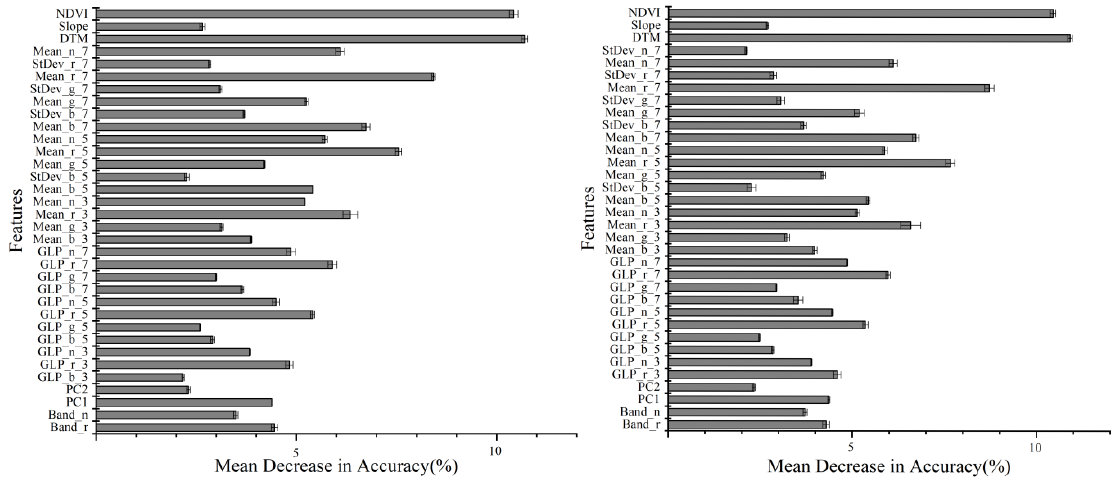
Figure 7. The average and standard deviation values of mean decrease in accuracy for different features in feature subset 1 ( left ) and 2 ( right ). As for features’ name, see Li et al. [12] for detail.